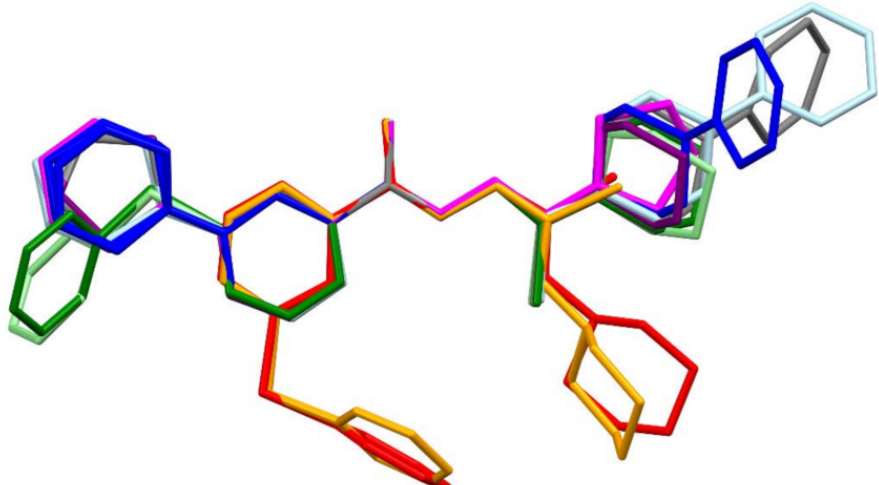
Figure 11. Overlay of molecules for all determined structures; 1 —red and orange, 2 —light green and green, 3 —magenta, 4 —light blue and blue, 5 —grey and 6